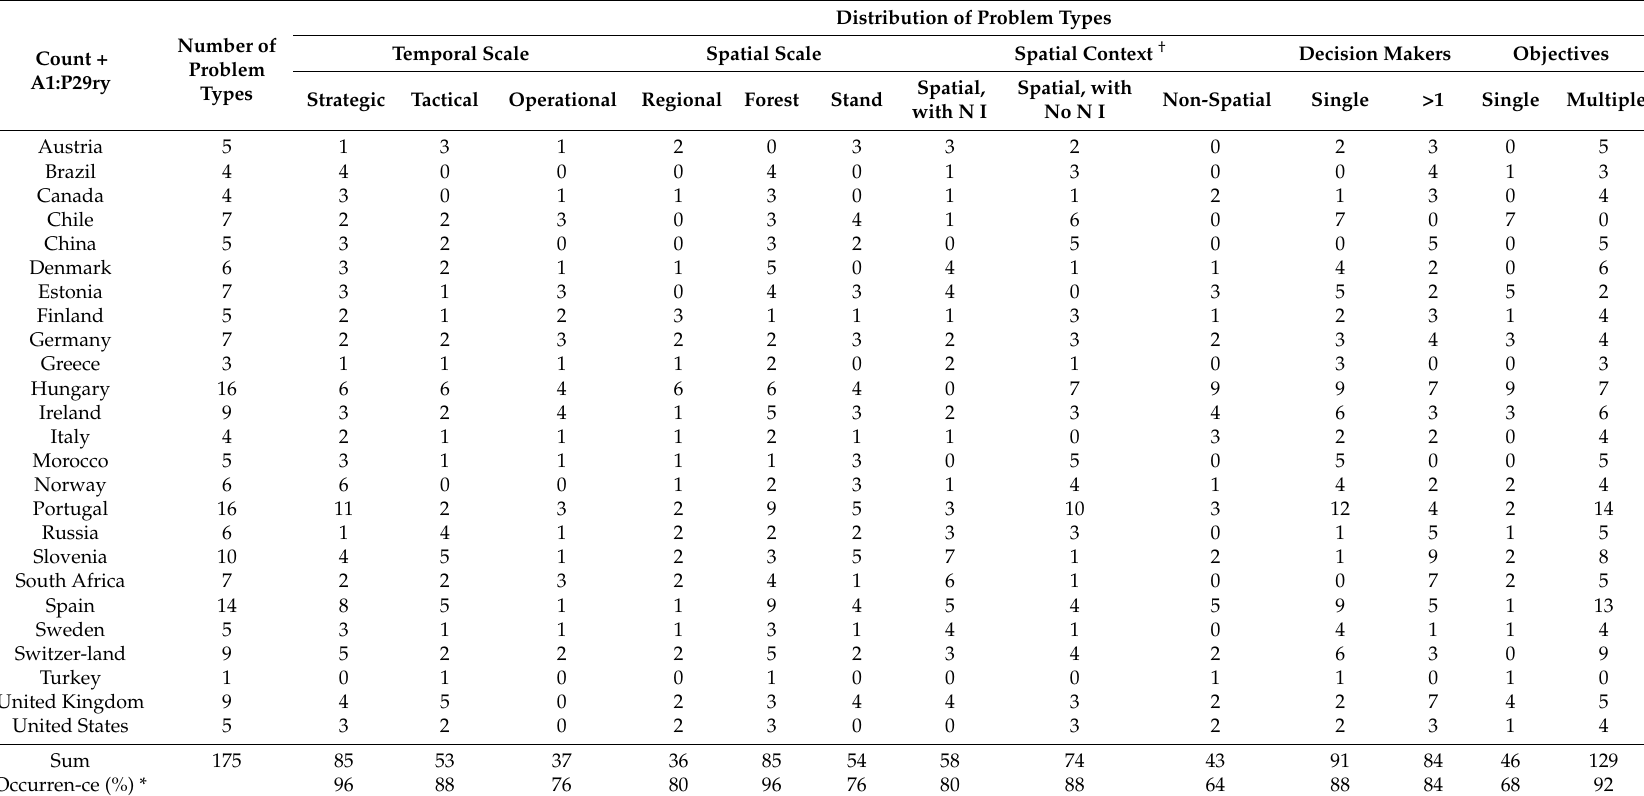
Table 1. The number of problem types, their corresponding dimensions, and